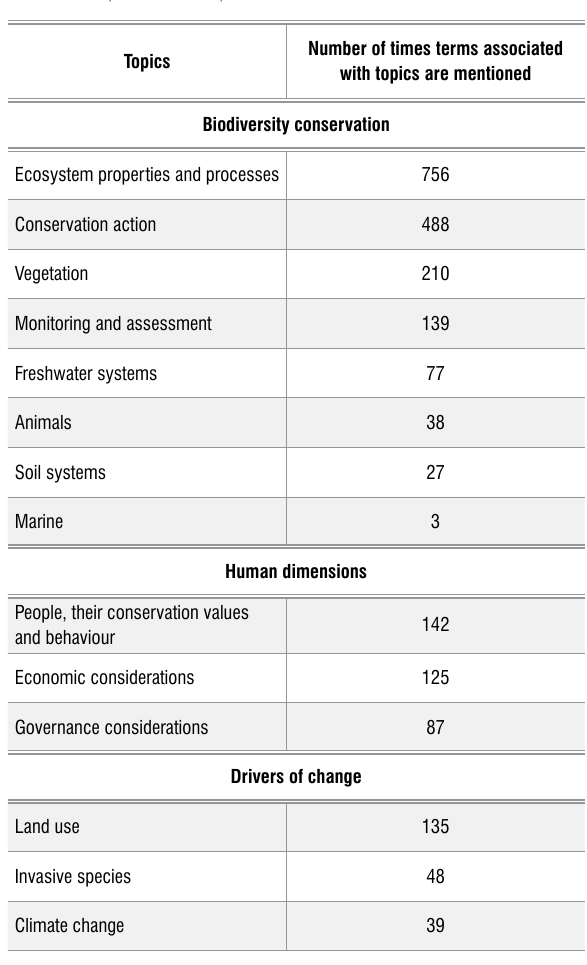
Clustering of terms used in respondents’ submitted questions